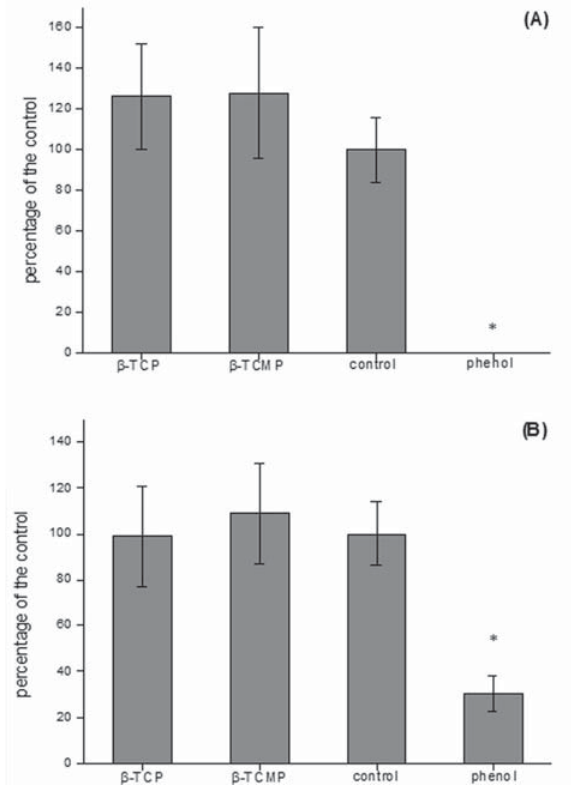
Figure 5- Cytotoxicity assay of tricalcium phosphate ( β -TCP) and magnesium-substituted β -TCP on mouse osteoblasts, indicated as means and corresponding standard deviations. (A) 2,3-bis[2-methyloxy-4 nitro- 5-sulfophenyl]-2H-tetrazolium-5-carboxanilide (XTT) reduction. (B) Crystal Violet dye elution. The